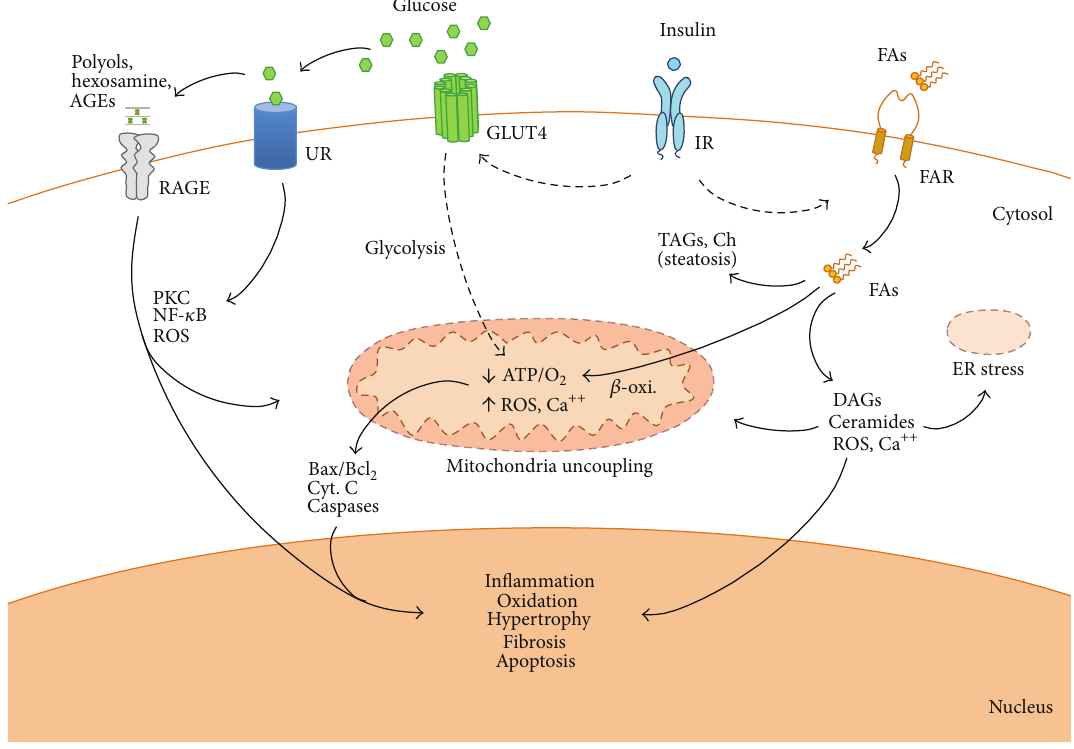
Figure 1: The diabetic milieu at the myocardium. Thickened lines represent activated pathways, and dotted lines denote reduced pathways. The absence of insulin response by defect in its secretion (T1DM) or sensibility (T2DM) promotes a lack of glucose assimilation for energy demand in the cardiomyocytes and extracellular glucose accumulation. Thus, FA may be the unique energetic substrate but 𝛽 -oxidation may saturate and lipid can accumulate and cause steatosis and lipotoxicity by DAG, ceramide, and ROS formation. These metabolites together with glucose derivatives (i.e., polyols, AGEs) damage the mitochondria and endoplasmic reticulum (ER) and regulate the expression of proinflammatory, hypertrophy, fibrotic, and apoptotic genes. RAGE, receptor for advanced glycation end products; UR, unspecific receptors; IR, insulin receptor; FAR, fatty acid receptors. Ch: cholesterol; Cyt. C: cytochrome-C.